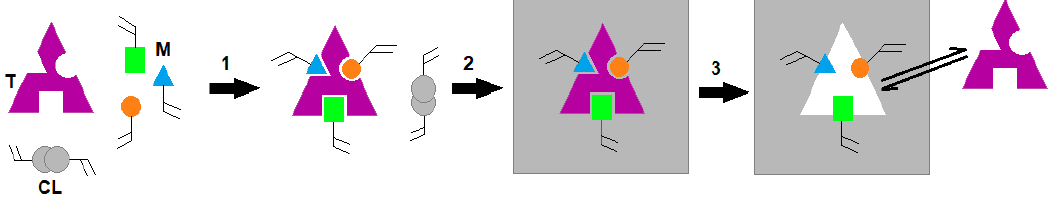
Figure 5. General principle of molecular imprinting technology.